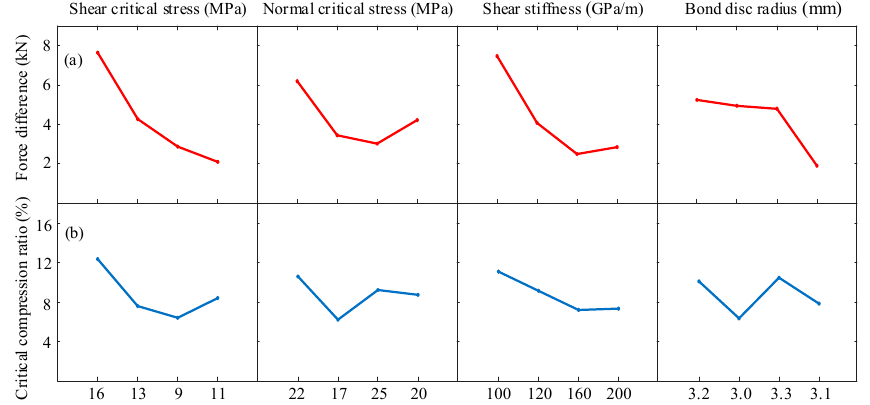
Figure 11. Marginal means graphs for two responses for the Brazilian test simulations: ( a ) force difference; ( b ) critical compression ratio.